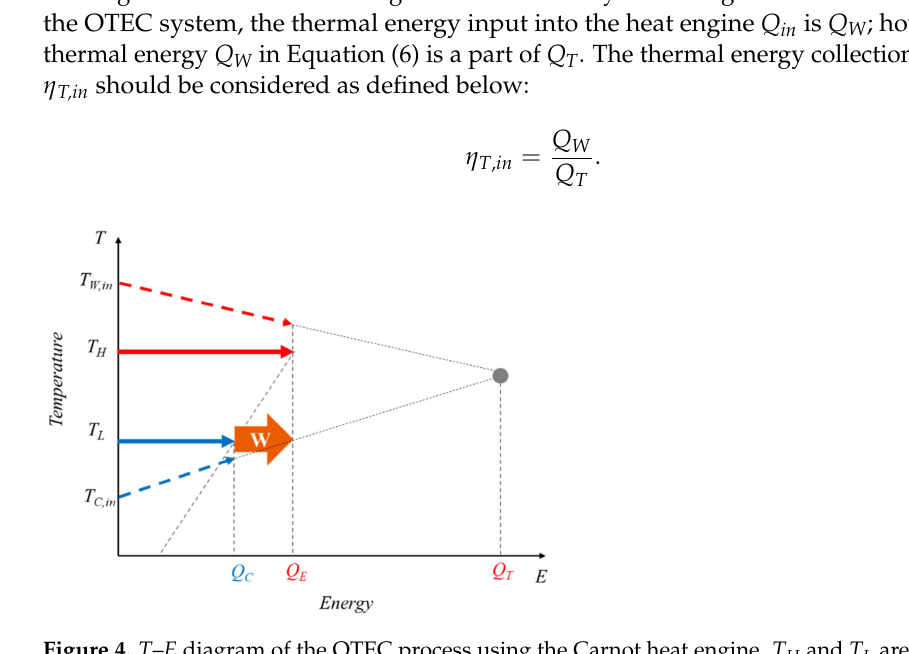
(cid:0) (cid:1) = (cid:0) mc p (cid:1) mc p , in Equation (8) [17]. W C